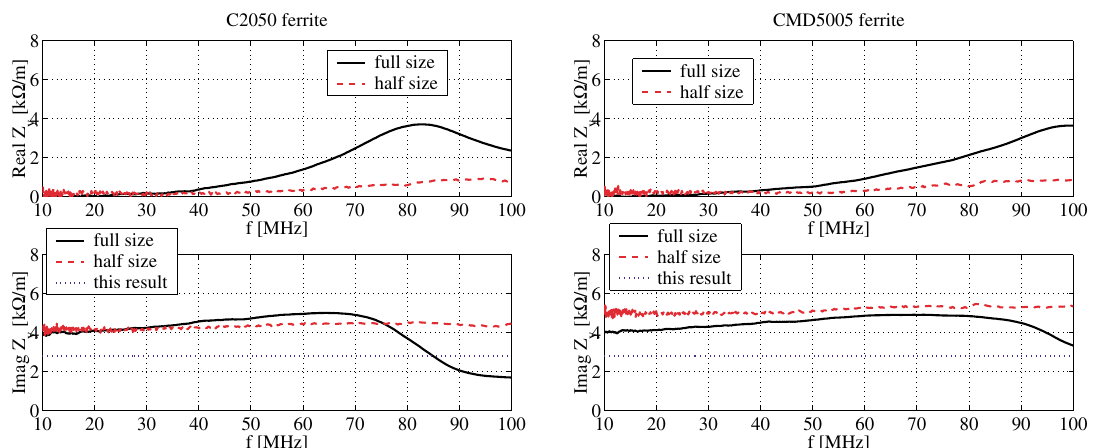
FIG. 9. (Color) Measured transverse impedances with shorted busbar, for half- and full-size kickers, two ferrite types compared with Eq.